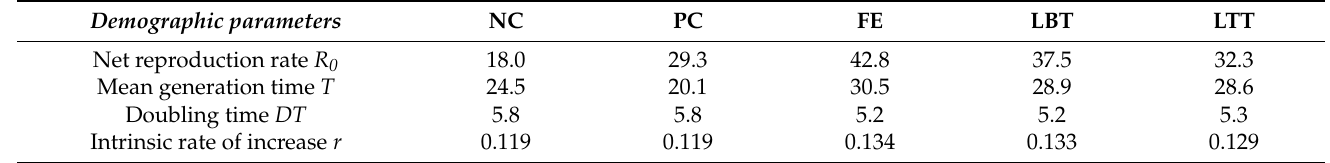
Table 1. Demographic parameters of Trichopria drosophilae held at 23 ± 0.5 °C, 70% RH, long day conditions and fed with various diets (NC = water, negative control, PC = honey, positive control; flowers of FE = Fagopyrum esculentum , LBT = Lobularia maritima ‘Benthamii’, LTT = L. maritima ‘Tiny Tim’) as adult females. Time unit of R 0 , T and r is [day]. N = 30 wasps per treatment. Demographic parameters NC PC Net reproduction rate R 0 Mean generation time T Doubling time DT Intrinsic rate of increase